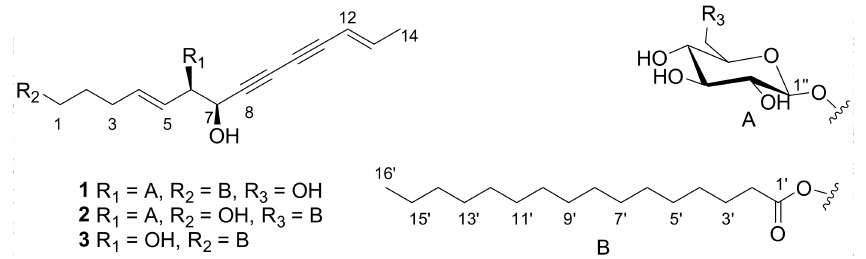
Figure 1. The structures of the compounds choushenpilosulynes A–C ( 1 – 3 ) from Codonopsis pilosula